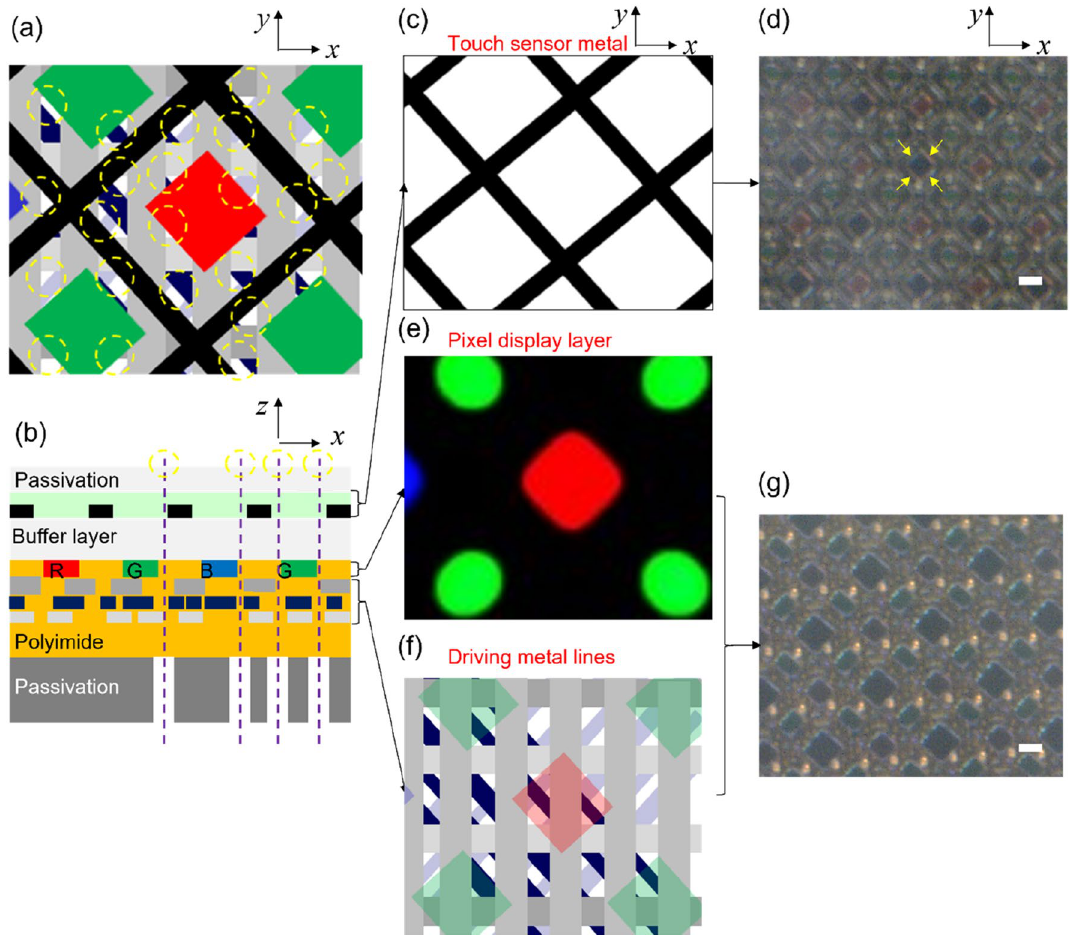
Figure 3. Schematic of stack structure for penetrated micro-sized holes patterns. ( a ) Combined layers with several penetrated micro-sized holes. ( b ) Cross-sectional view of the smartphone stack structure. ( c ) Schematic of touch metal sensor panel. ( d ) Optical microscope image of touch sensor metal lines aligned along the perimeter of sub-pixels (yellow arrow), scale bar: 20 µm. ( e ) Display layer with red, green, and blue sub-pixels. ( f ) Driving metal lines layer. ( g ) Optical microscope image of combined layers with pixel display layer and driving metal lines layer, scale bar: 20 Stack structure of touch sensor and pixel display panels for penetrated patterns. In mass- produced smartphones, except for red, green, and blue pixels, the driving metal wiring and touch sensor panel wiring are densely formed. In typical OLED display panels in smartphones, the transparent portions of the white area within the yellow circle in Fig. 3a,b cover only a few dozens square micrometers per pixel. In the cross-sectional region of general smartphones, as shown in Fig. 3b, the transparent areas passing through several opaque layers of the upper and lower parts are formed arbitrarily. As shown in Fig. 3c,d, the uppermost layer is formed by surrounding the sub-pixel with a transmitter and receiver metal mesh pattern, which results in capacitance changes upon sensing touch. Under the touch sensor panel, the pixel display layer is patterned for the red, green, and blue pixels, as shown in Fig. 3e. Electric and driving wires of the electroluminescence pixel power supply (ELVDD), electroluminescence ground power supply (ELVSS), data, and transistor electrode lines for the emitting pixels are formed at the lower layer of the pixel display layer, as shown in Fig. 3f. Figure 3g shows an OLED display screen pixel image of a commercial smartphone. However, even the non-overlapping areas of commercial smartphone displays appear black under a microscope because of the passivation layer and the protective film that shields the display panel. Hence, to perform fingerprint sensing on a display screen, it is nec- essary to pattern or remove the opaque areas of the protective film under the display screen, as shown in Fig. 3b. Owing to the structure of commercial smartphones, only several transparent holes of 10 µm × 10 µm or less can be created in smartphone display panels. Therefore, employing multiple openings with a size of 10 µm is more advantageous for display panels in actual smartphone applications, as compared with using one large aperture. Different spectral properties of green OLEDs and QLEDs. Green OLEDs and QLEDs were fabricated as stack structures, as shown in Fig. 4a,b. The green OLED consisted of indium tin oxide (ITO) as the anode, 1,4,5,8,9,11-hexaazatriphenylene hexacarbonitrile (HAT-CN) as the hole-injection layer (HIL), 1,1-Bis((di-